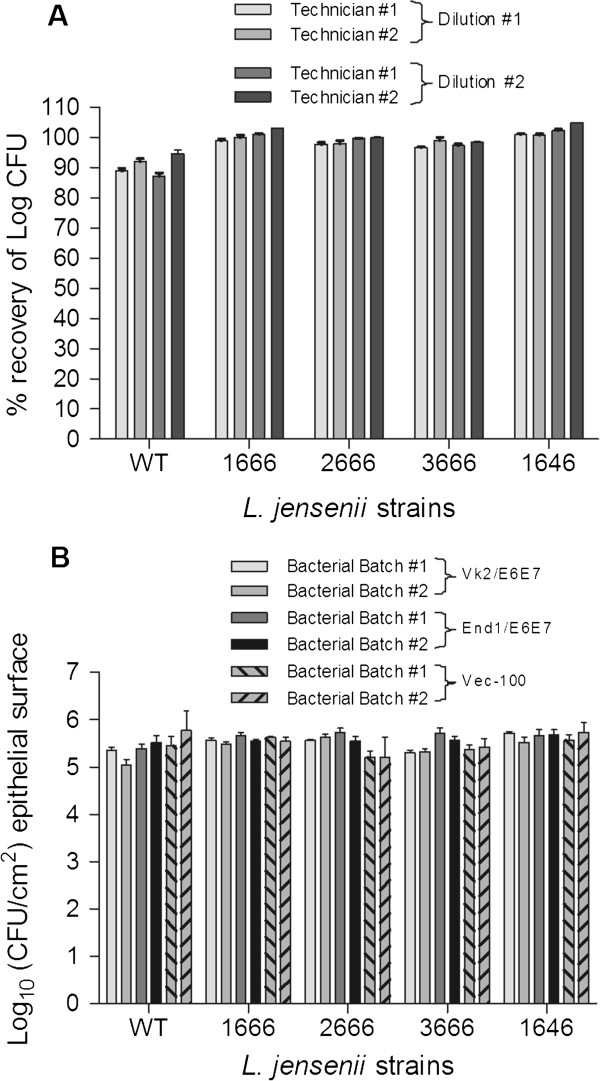
Technical standardization elicits reproducible results in colony forming units. L. jensenii 1153 wild type (WT) and bioengineered L. jensenii 1153–1666, 2666, 3666 and 1646 strains before and after coculture with vaginal and cervical epithelia. (Figure 2a) Full recovery from frozen bacterial stocks and technical reproducibility assessed by % recovery of log CFU in multiple dilutions of quadruplicate cultures prior to epithelial coculture. (Figure 2b) L. jensenii strains at 7x106 CFU/ml colonize vaginal (Vk2/E6E7), primary (VEC-100™) and immortalized (End1/E6E7) cervical epithelia at a consistent rate in two separate batches of multiple experiments. Bars represent mean and SEM of triplicate or quadruplicate cultures.